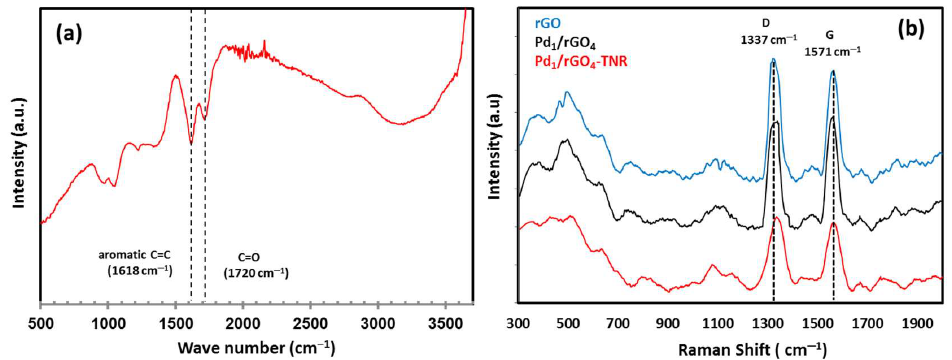
Figure 2. ( a ) FTIR spectrum of pristine rGO. ( b ) Raman spectra of pristine rGO, Pd 1 /rGO 4 and Pd 1 /rGO 4 -TNR.